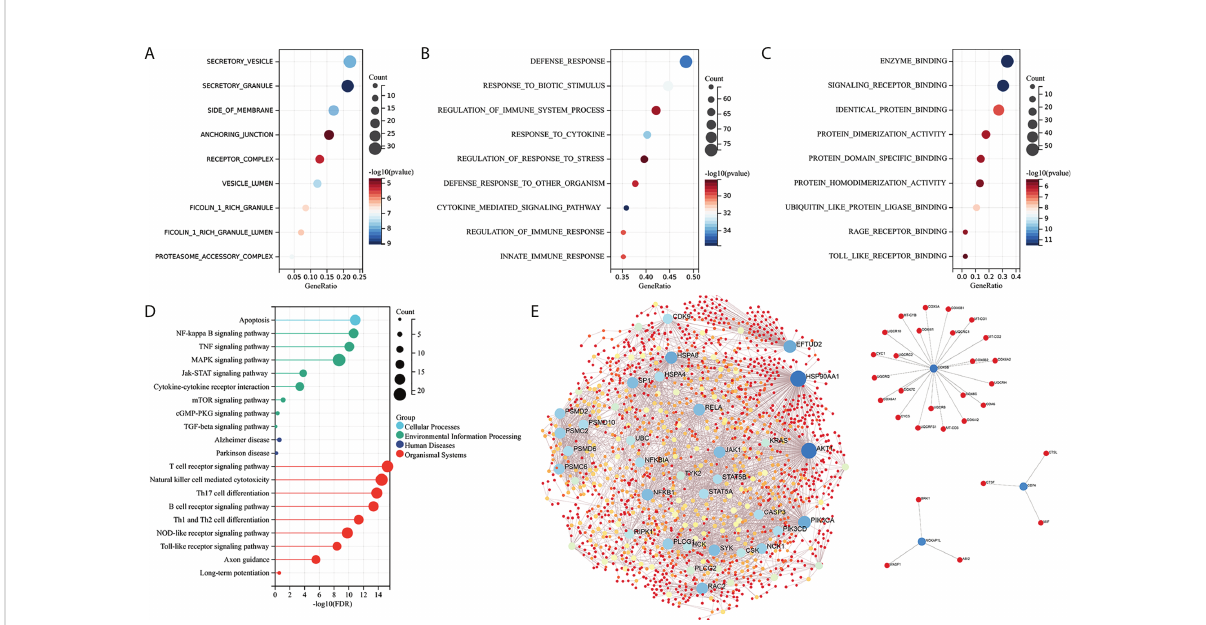
FIGURE 3 Enrichment analysis and PPI network construction of IRDEGs. (A – C) GO function enrichment analysis (cellular components, biological process, and molecular function). (D) KEGG pathway enrichment analysis. (E) PPI network of IRDEGs. GO, Gene Ontology; KEGG, Kyoto Encyclopedia of Genes and Genomes; PPI, protein – protein interaction; IRDEGs, immune-related different expression